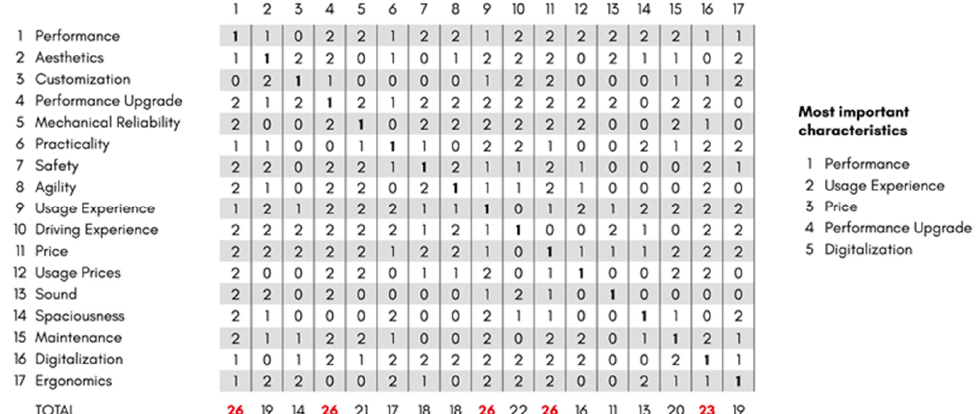
Figure 7. Relative importance relationship matrix.